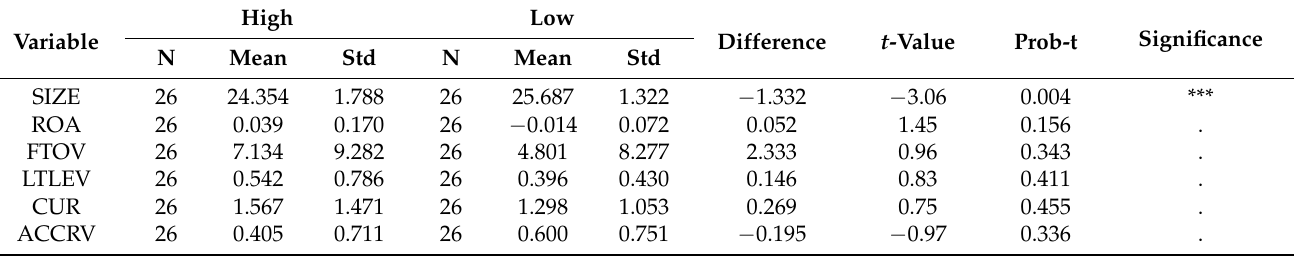
Table 5. The mean difference of TF/IDF of IP perspective between high (1,2) and low (4,5) quintile. Variable